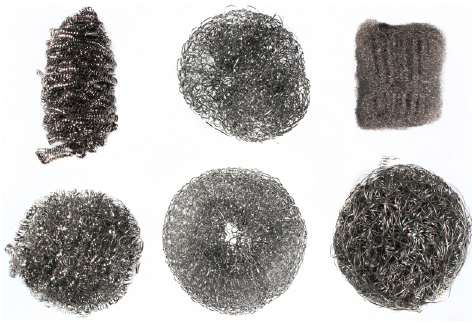
Figure 4. Photographs of six steel wool specimens found on the market in Douala/Cameroon (August 2015). The thickness of SW fibers ( µ m range) suggests that they can deplete within a year or some within two years upon aqueous corrosion [136,137]. This makes SW a practical material to start characterization of key aspects of the long-term Fe 0 efficiency (sustained reactivity), both at lab and field scales. Long-term parallel experiments with SW (e.g., diameters 30 to 300 µ m—ref. [136]) and thicker Fe 0 materials (e.g., shopped iron wires of different diameters >300 µ m) are recommended in this